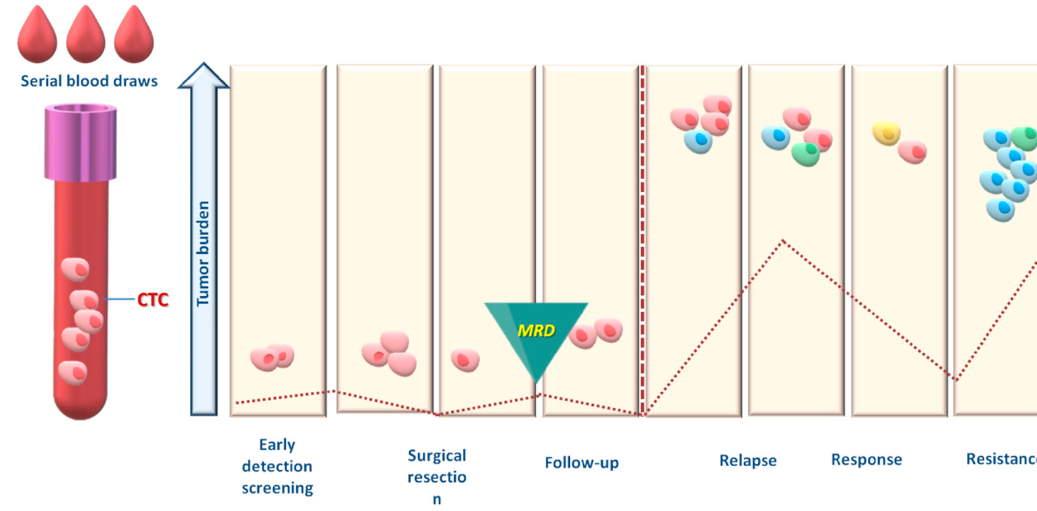
Figure 1. Applications of CTC analysis for the follow-up of cancer patients.